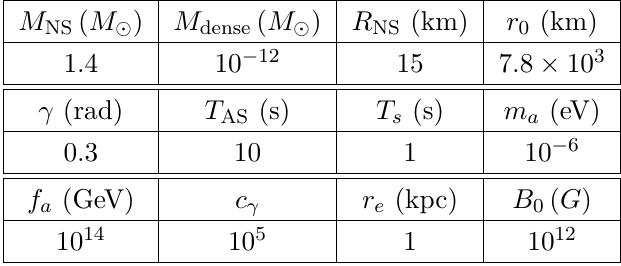
Table 1 . A table with the relevant constants of our